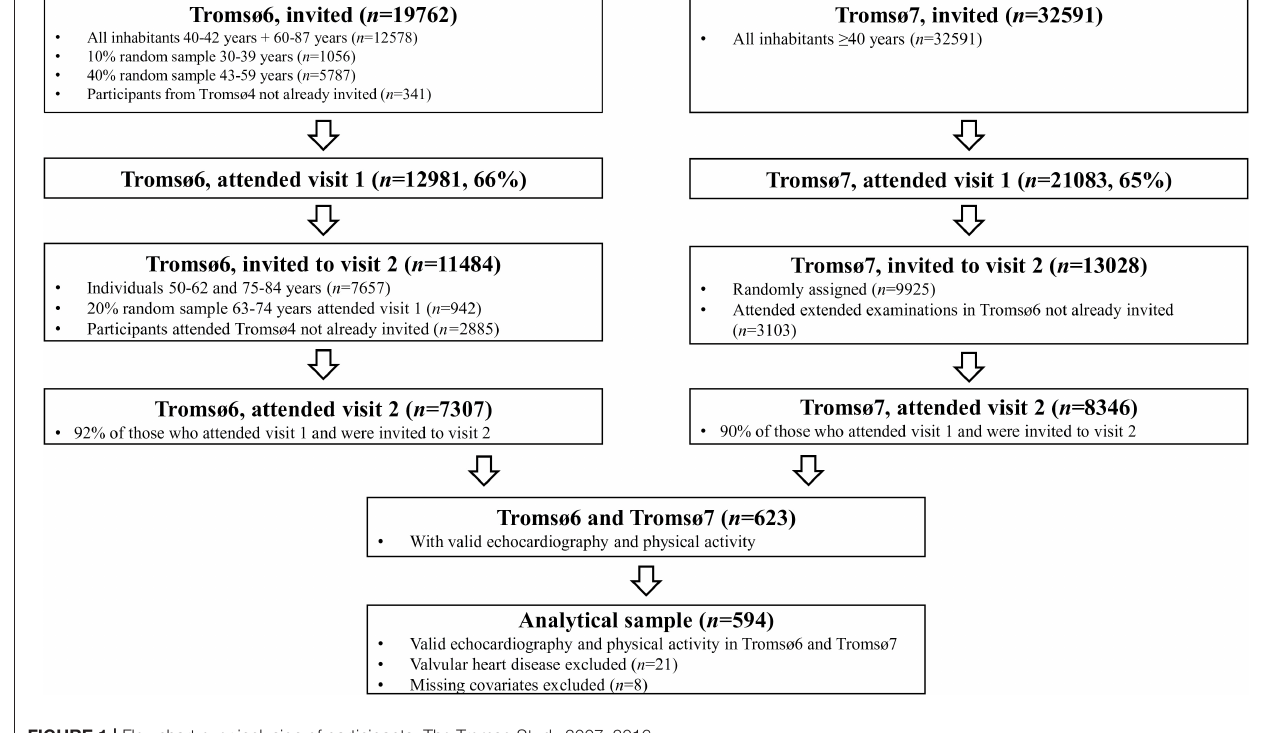
FIGURE 1 | Flowchart over inclusion of participants: The Tromsø Study 2007–2016.